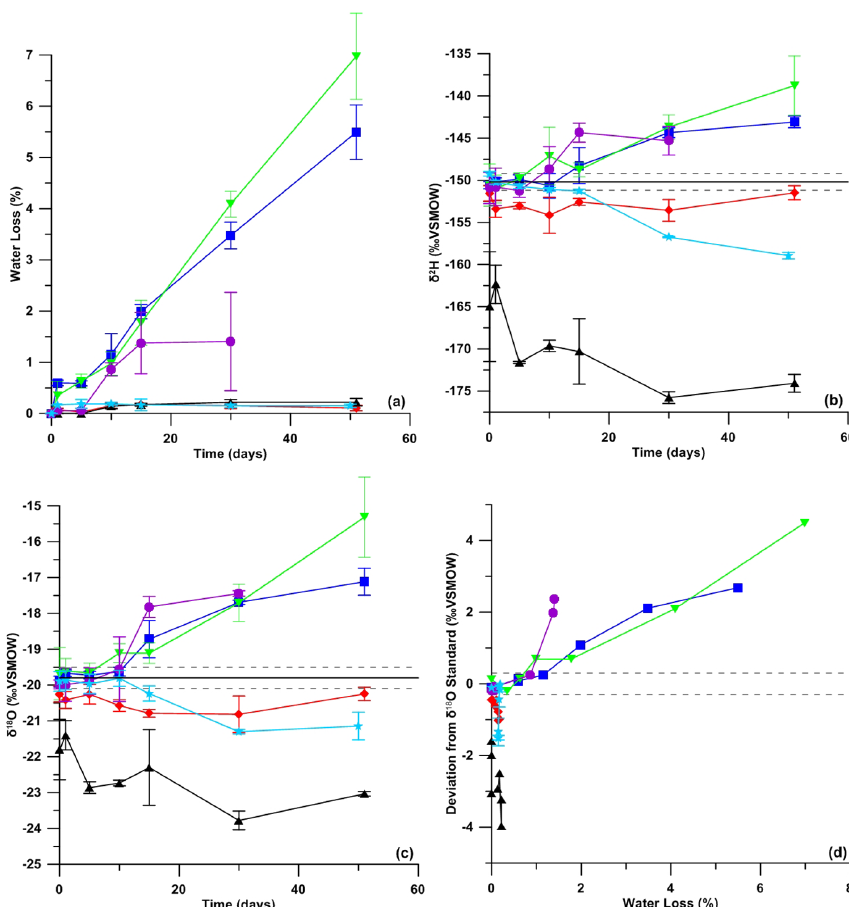
Figure 11. Analytical results (mean and standard deviation of triplicate samples) of (a) water loss, (b) δ 2 H, (c) δ 18 O in pore water with time for each bag tested, and (d) water loss vs. deviation from the δ 18 O isotope standard value. Types tested included Ziploc ™ bags (blue squares), crystal clear ™ bags (green inverted triangles), mylar bags (red diamonds), black bags (black triangles), IsoPaks ™ (purple circles), and silver pouches (pale blue stars). The δ 2 H and δ 18 O of the test pore water are presented as horizontal solid lines, with the associated standard errors presented as dashed lines ( δ 2 H =± 0.8‰; δ 18 O =±